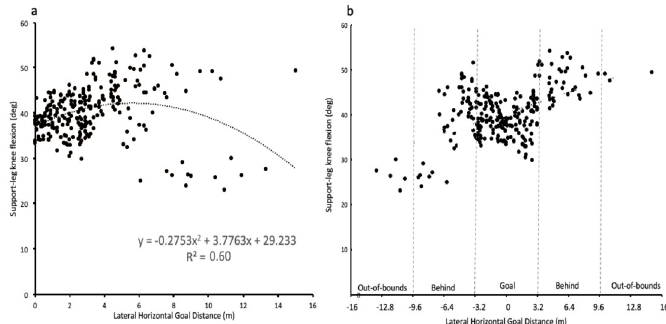
Fig 7. The relationship between accuracy and support-leg knee flexion; (a) a moderate quadratic relationship between support-leg knee flexion and accuracy, and (b) alterations in support-leg knee flexion in relation to left and right side of